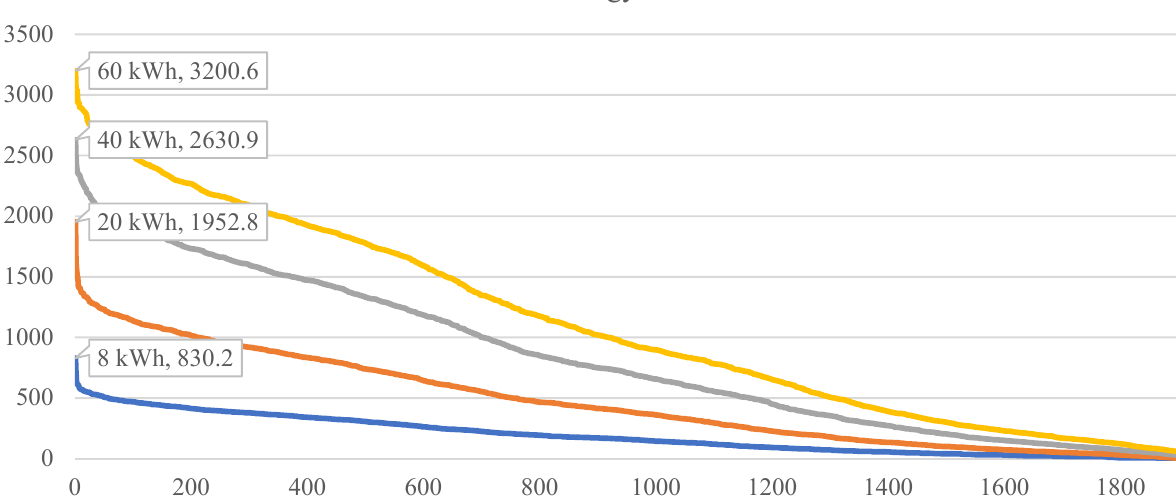
Figure 11. Sorted summed connector power when employing the naive strategy. For example, if during each charging process 40 kWh is to be charged, during ~800 h of the observed 1921 h, the chargers consumed 500 kW or less.